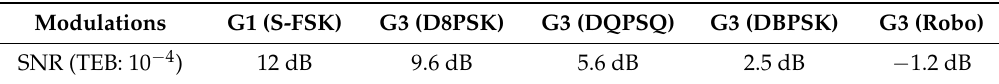
Table 1. SNR maximum value for the G1-PLC and G3-PLC technologies. Modulations